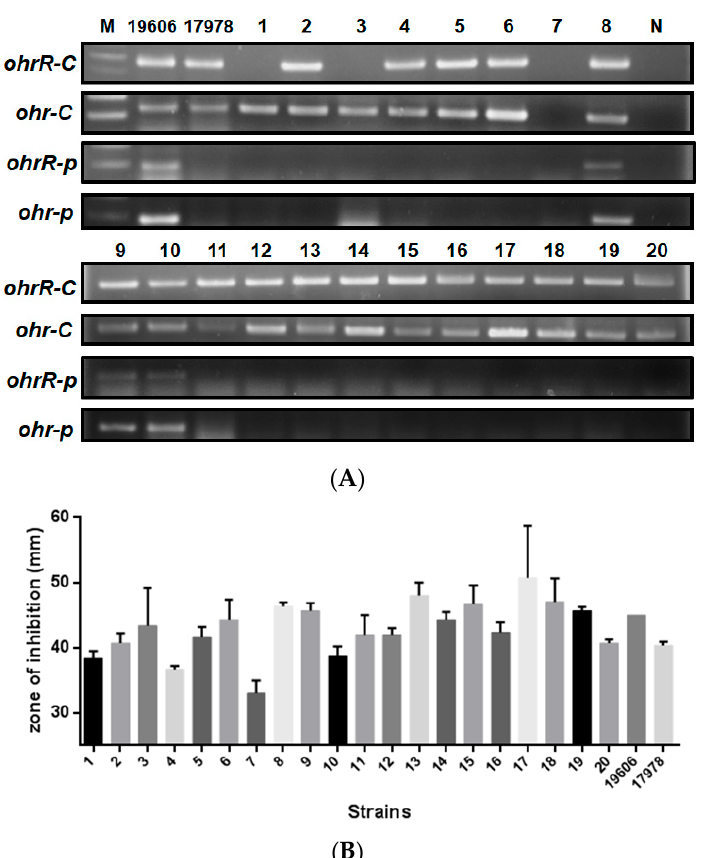
Figure 2. Presence of ohrR-ohr genes and t BHP resistance of 20 Acinetobacter isolates. ( A ) PCR products amplified by primers specific to chromosomal or pMAC ohrR-ohr genes. ( B ) Inhibition zones for each isolate following treatment with 135 μ g of t BHP in a disk diffusion assay. Numbers 1–20 indicate the strain numbers of Acinetobacter isolates. M is a molecular weight marker. N is a negative control using ddH 2 O as a template. 19606 and 17978 indicate A. baumannii ATCC 19606 and ATCC 17978, respectively. These data were obtained from three independent experiments.